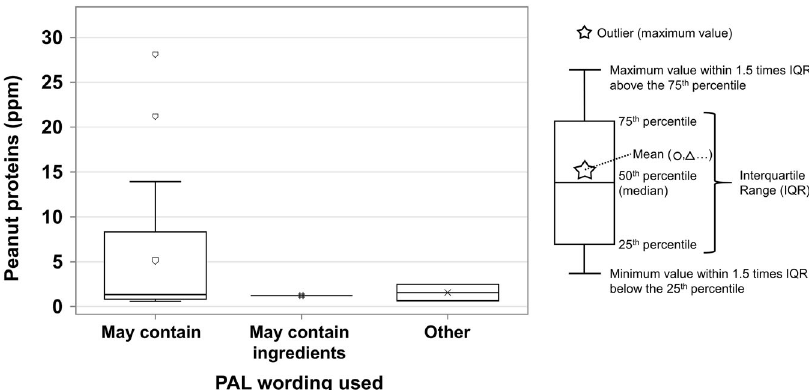
Fig. 1 Peanut protein concentration by PAL statement used. Each box represents a different PAL wording and has a different color-symbol combination. The “ May contain ” category presents two outliers. There were no positive results for “ May contain traces ” in products with a PAL for peanuts.